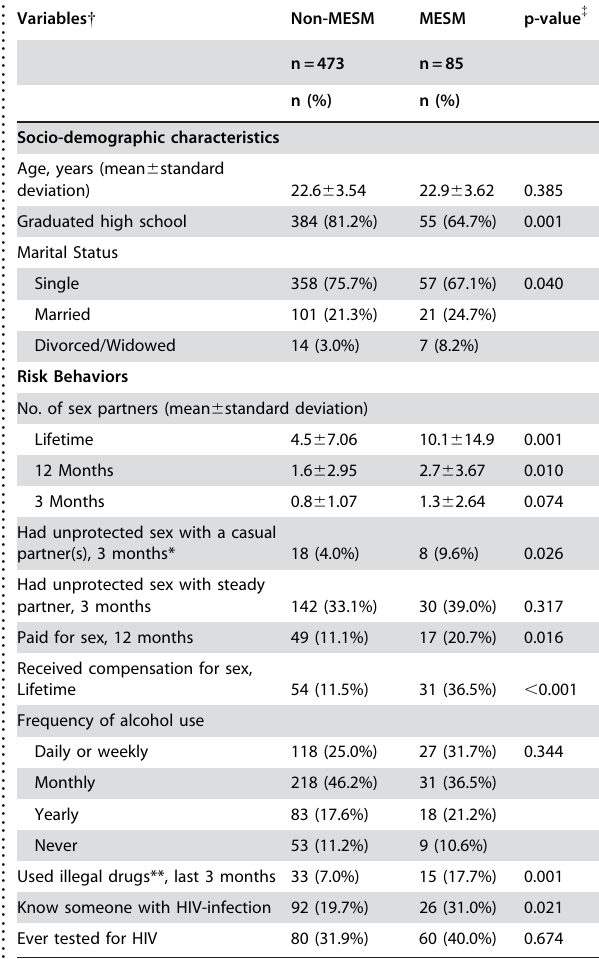
Table 1. Participant characteristics and risk behaviors among general population males: Lima, Chiclayo, and Trujillo; Peru,